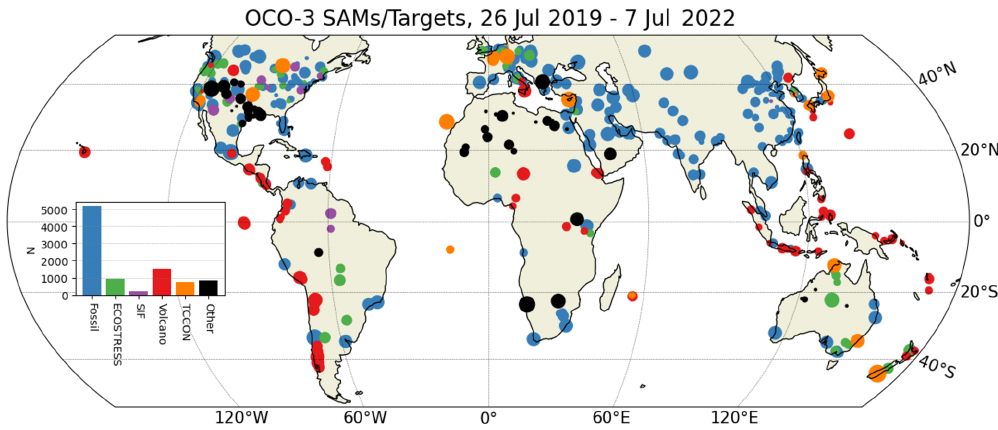
Figure 4. Map of all OCO-3 SAMs and targets recorded through July 2022, categorized by site type.